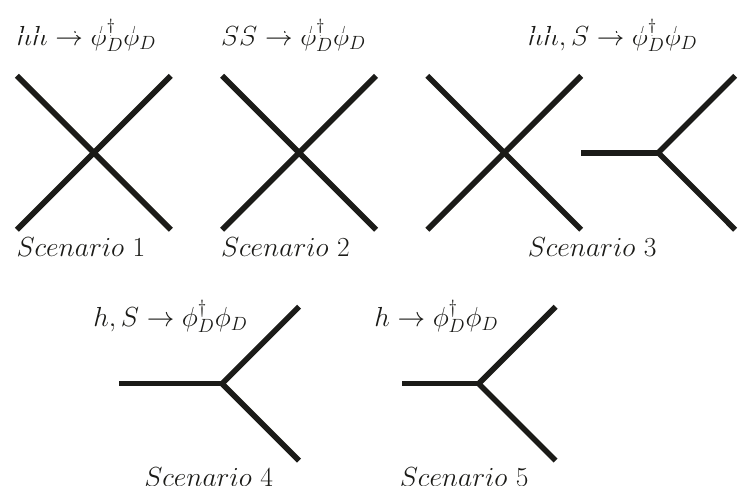
Figure 2 . Schematic diagrams for different dark matter production scenarios, Scenario-(1-5)